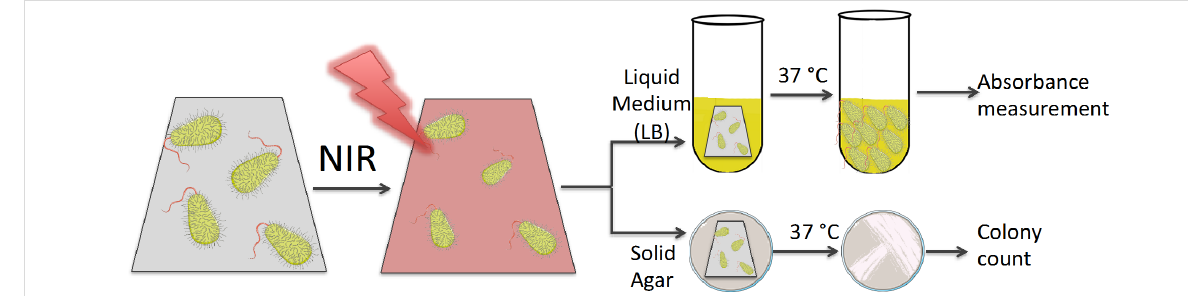
al purposes, Escherichia coli (DH5-alpha strain) were inocu- lated onto PVA without GNSs (as control) and PVA-GNS films, and then exposed to NIR laser irradiation (using